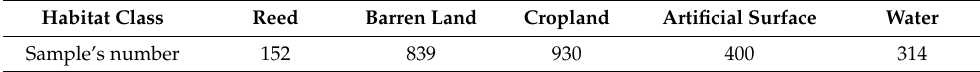
Table 2. Sample number of each